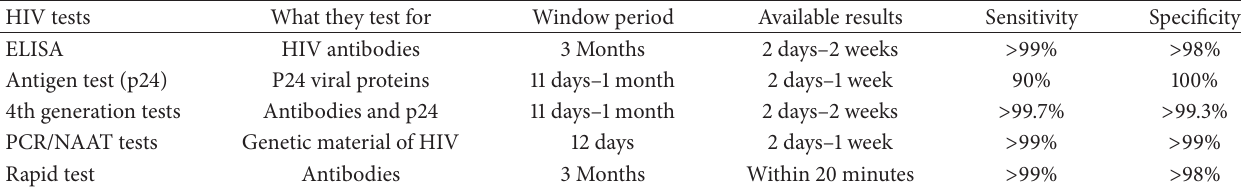
Table 1: Testing modalities for diagnosing HIV in pregnancy ∗ .